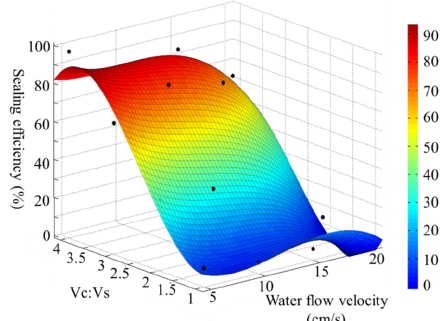
Figure 14. Influence of the initial water flow velocity and the mixture ratio of grout on the sealing efficiency.